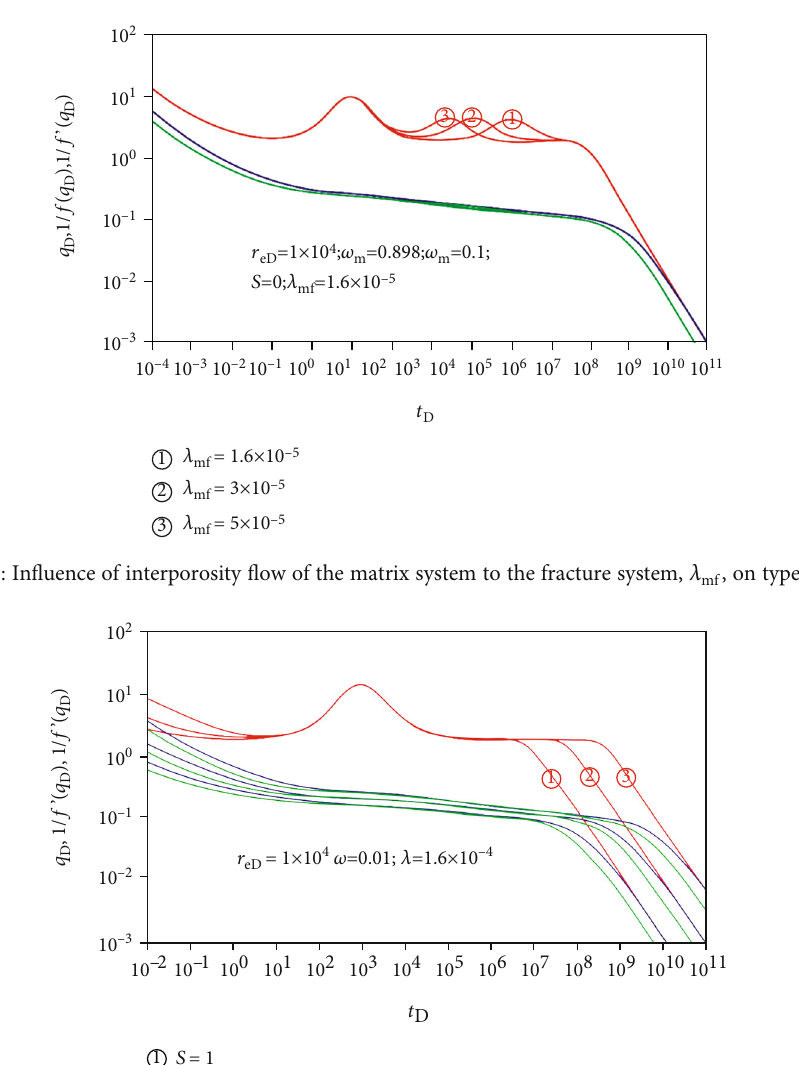
Figure 13: In fl uence of the skin factor, S , on type